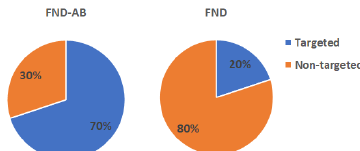
Figure 5. Distance measurement from particles to the border of the nucleus. Experiments were performed in 10 cells. Significance level was set at 0.05. **** indicates p < 0.0001. Error bars represent standard errors.